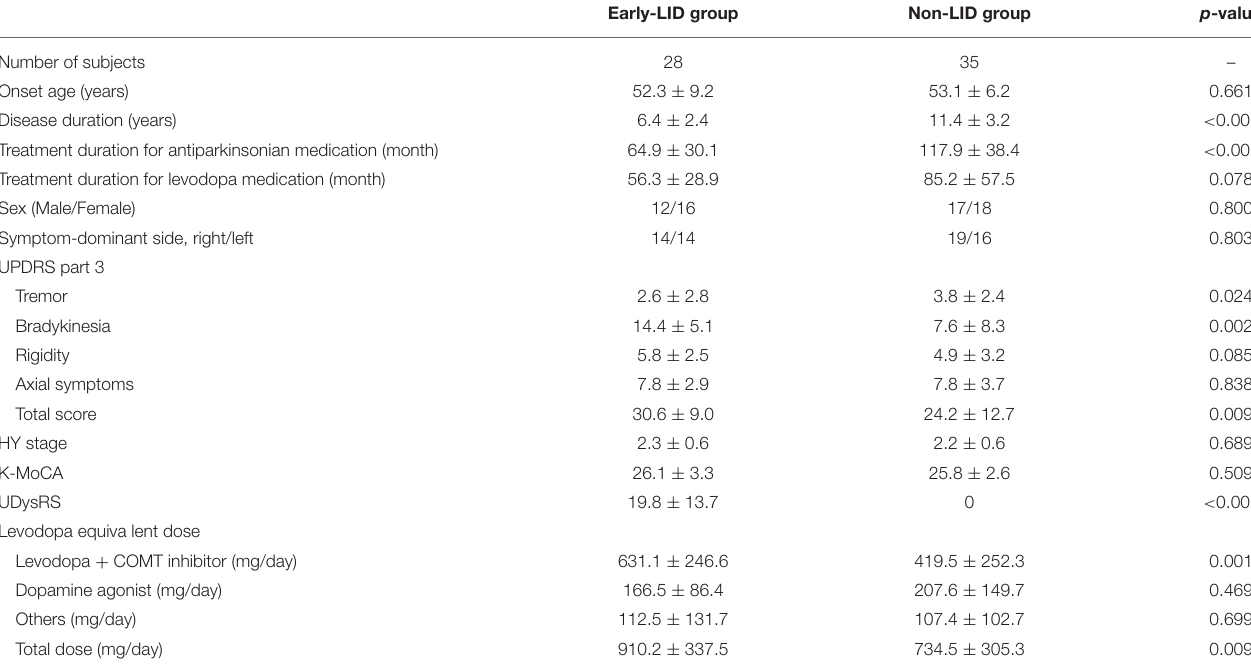
TABLE 1 | Demographic information of PD with and without LID.